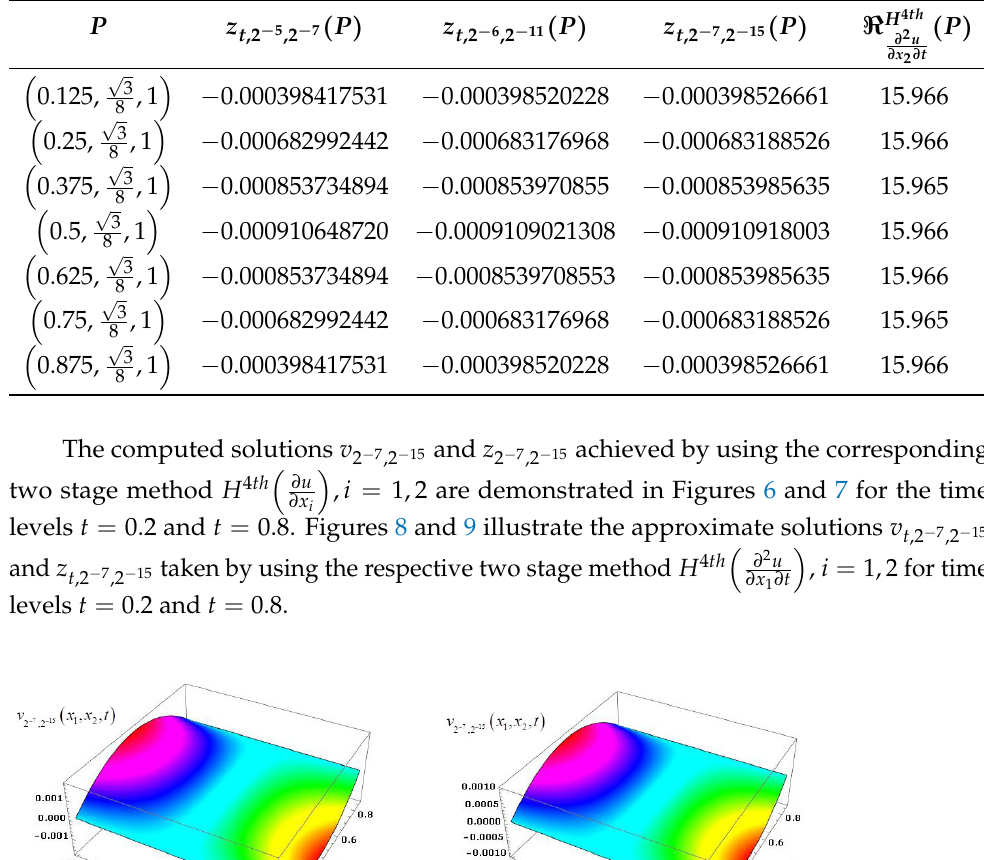
Table 7. The numerical solution z t , h , τ at seven points when t = 1, and the convergence orders ) for the Example 2. obtained by H 4 th ( ∂ 2 u ∂ x 2 ∂ t